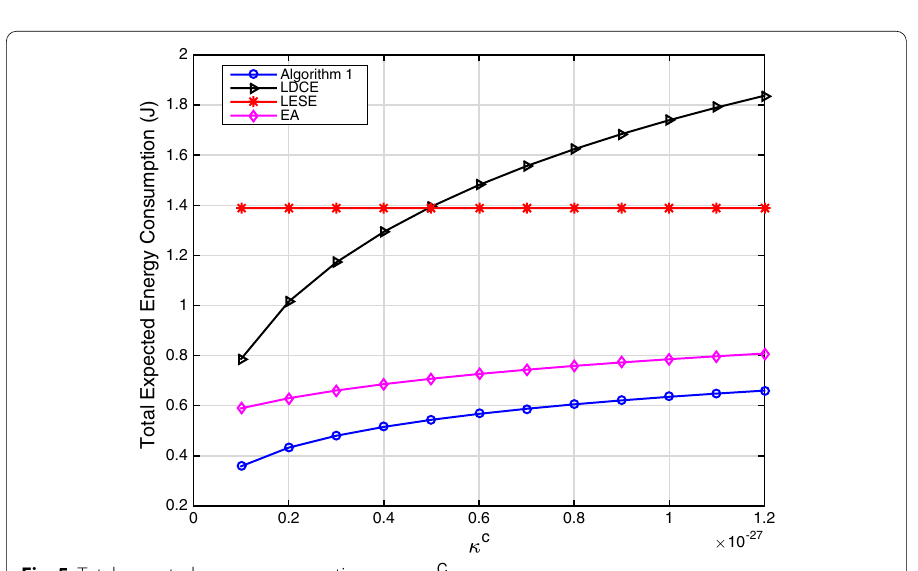
Fig. 5 Total expected energy consumption versus κ